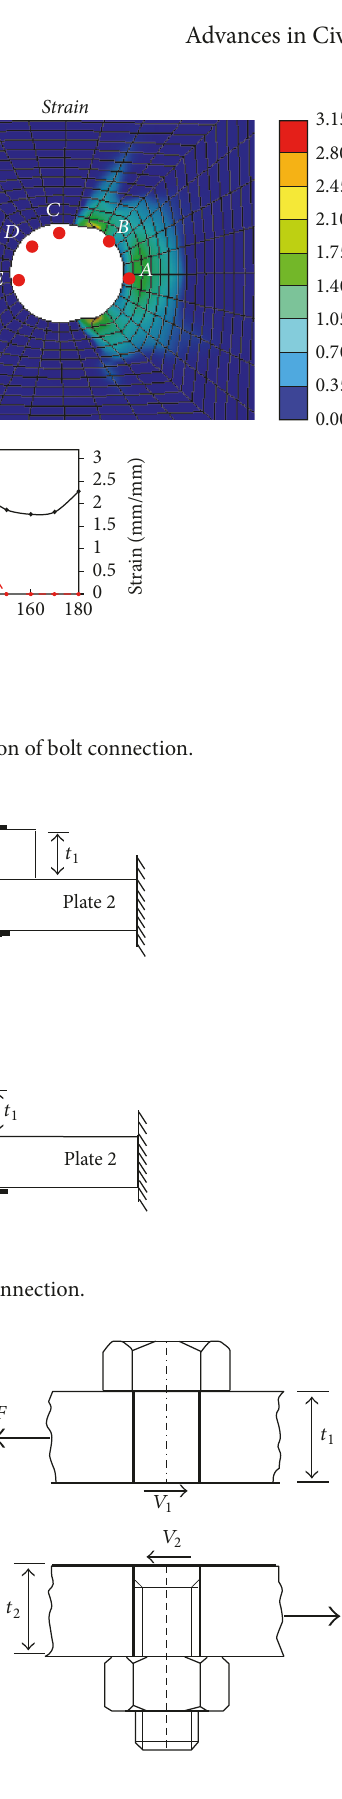
Figure 8: Forces in